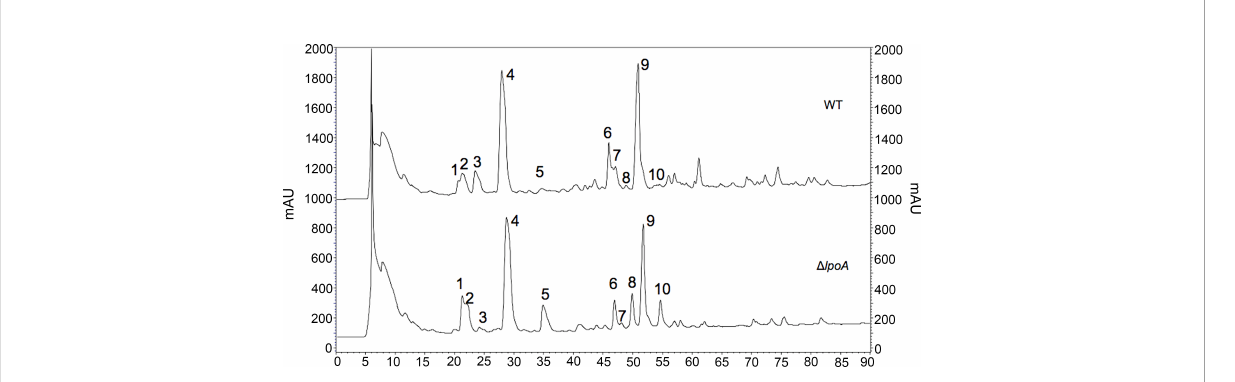
FIGURE 3 Aberrations in the cell wall of isogenic D lpoA. HPLC analysis of PG fragments (muropeptides) generated by digestion of PG from H. in fl uenzae 3655 wt (upper panel) and D lpoA (lower panel) strains with muramidases (lysozyme and mutanolysin). Muropeptides were reduced by sodium borohydride and separated by HPLC. mAU , absorbance unit × 10 3 at 207 nm. The identity of the main monomers (peaks 1-5) and dimers (peaks 6-10) was con fi rmed by amino acid and hexosamine composition analysis (see Table 2).